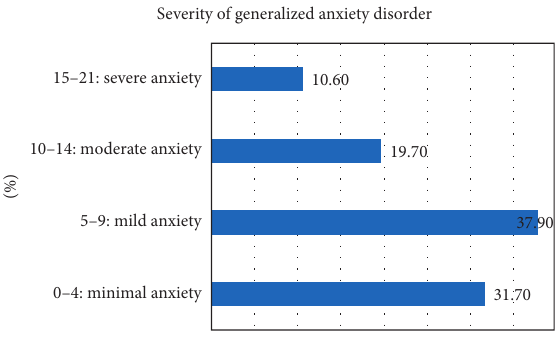
Figure 1: Distribution of the severity of generalized anxiety disorder among pregnant women. Table 3: Univariate and multivariate linear regression models: correlation between GAD and DA and other covariates. Study